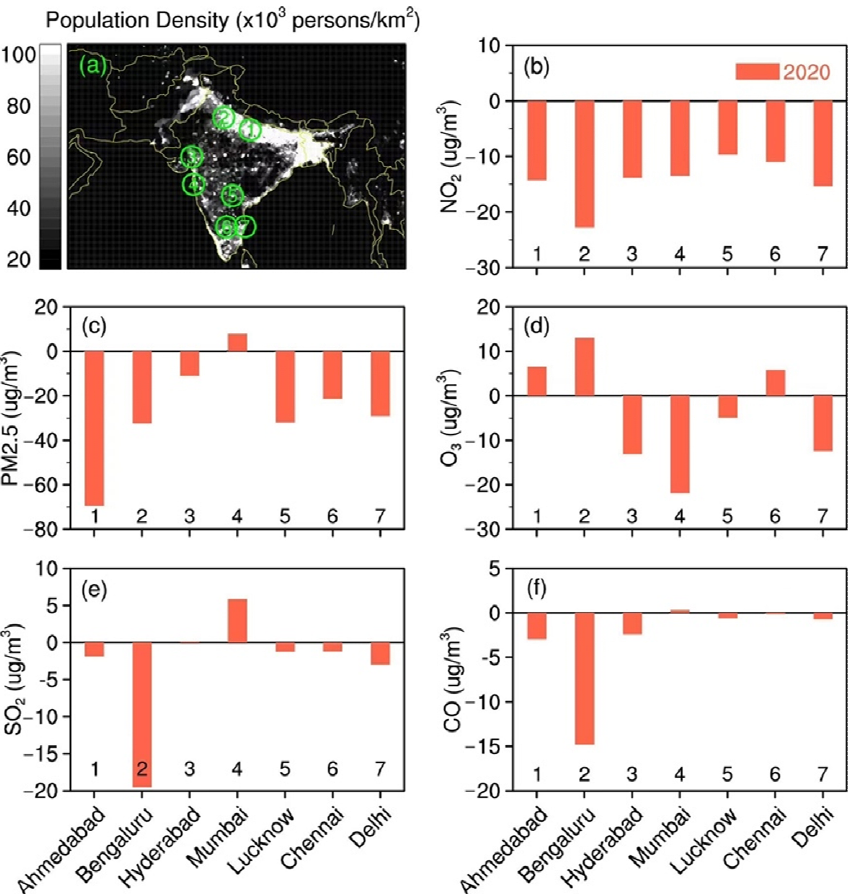
Figure 5. ( a ) Population density (×10 3 persons/km 2 ). ( b – f ) The changes (lockdown minus climatol- ogy) of near surface NO 2 , PM 2.5 , O 3 , SO 2 , and CO at 7 cities in 2020 (light-red bar). Data are from surface station observations.